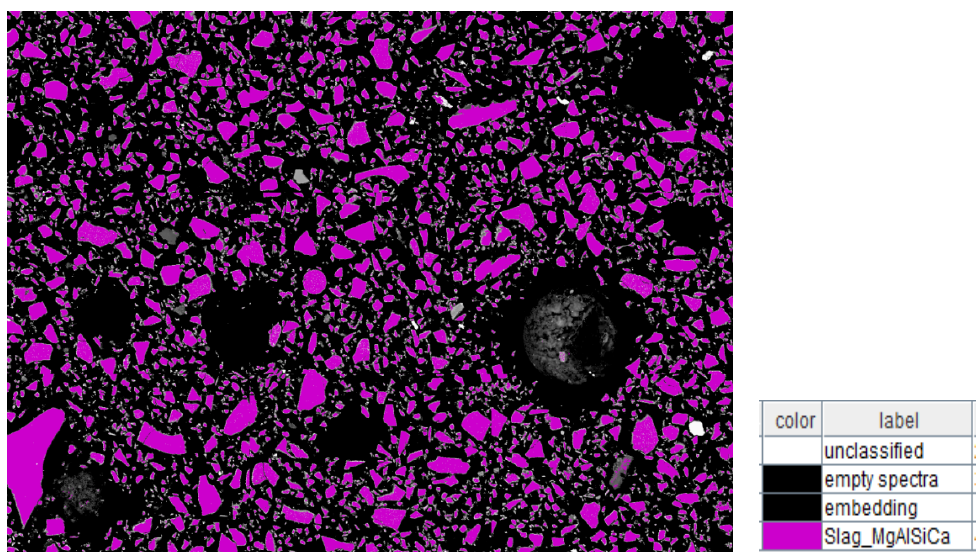
Figure 9. Large-area PARC phase map of the unreacted GBFS (( left ) (image width: 768 µ m)) and the legend of group phases identified in the unreacted GBFS ( right ).